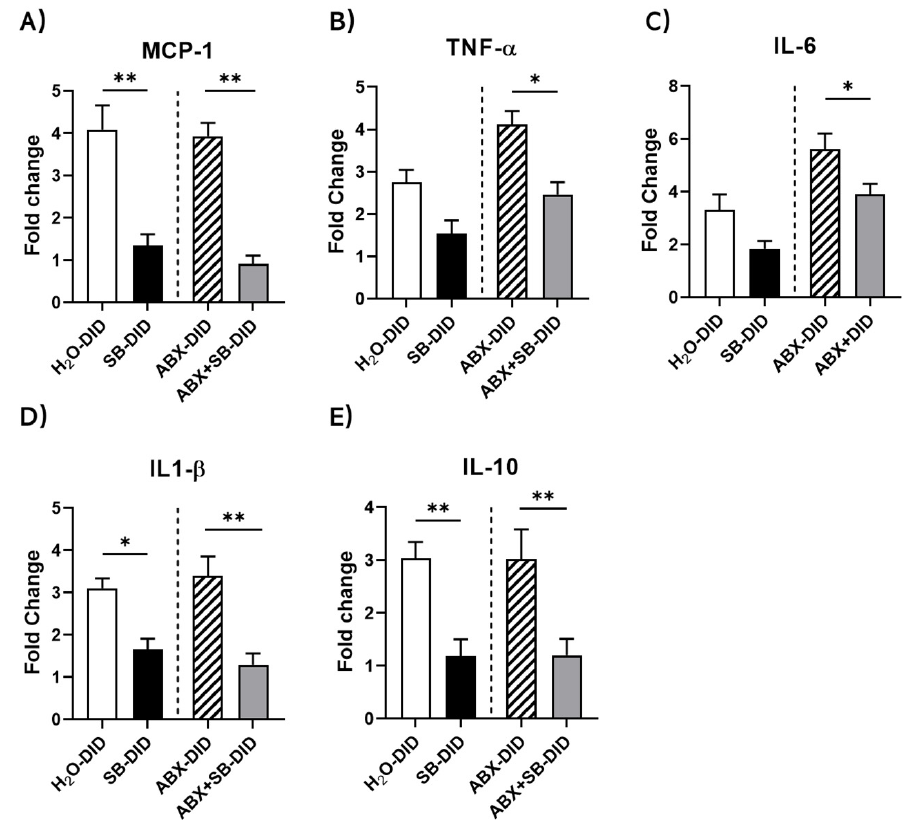
Figure 2. The effects of SB supplementation on DID- and/or ABX-enhanced increases in mRNA levels of pro- and anti-inflammatory cytokines in mouse brains. SB lowered the mRNA expression level of ethanol-induced pro-inflammatory cytokines MCP-1 ( A ), TNF- α ( B ), IL-6 ( C ) and IL-1 β ( D ) and anti-inflammatory cytokine IL-10 ( E ) with and without ABX treatment. The mRNA levels were assessed by real-time RT-qPCR. Data are presented as Mean ± SEM, n = 7–9/group. * p < 0.5, ** p < 0.01, for panels A,B,D,E Ordinary one-way ANOVA with Tukey’s multiple comparisons were used; for panel C, non-paired Mann–Whitney test was used.